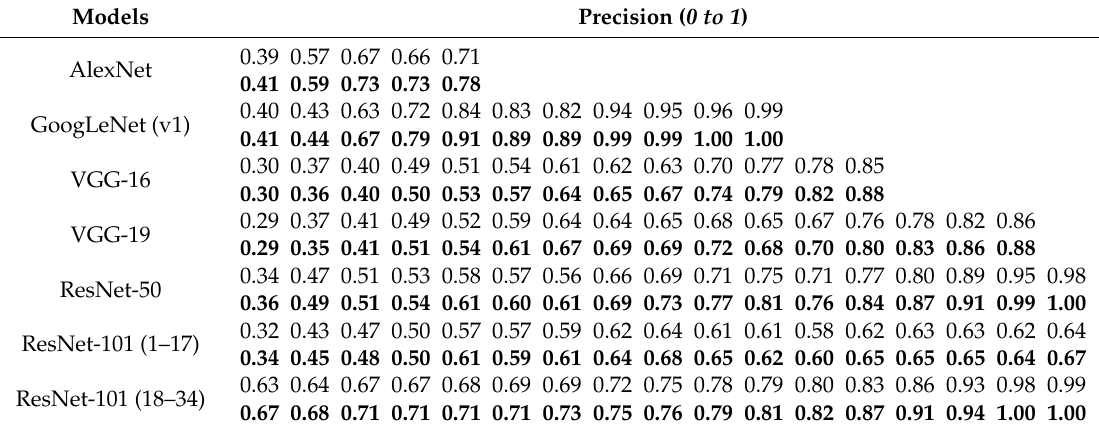
Table 3. Precision of cache with and without distance